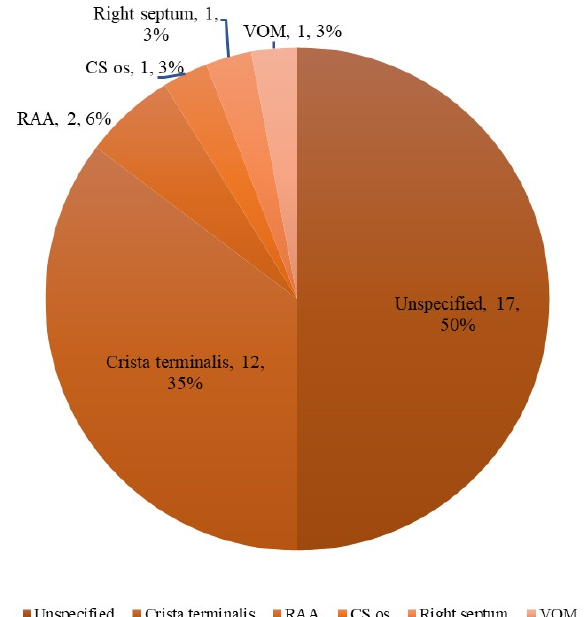
Figure 2. Trigger sites of adenosine-induced atrial fibrillation and recurrence rate after ablation of trigger site. RAA = right atrial appendage; CS os = crista terminalis ostium; VOM = vein of Marshall unspecified. The trigger sites were unspecified, but CS and RA catheters or circular mapping catheters indicated that RA was the trigger site.